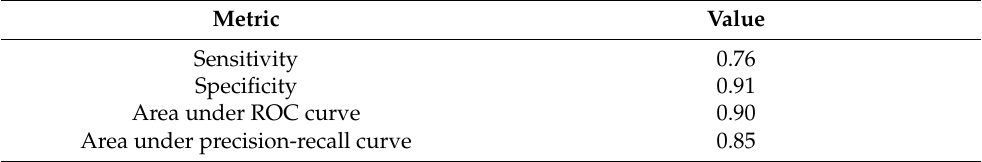
Figure 3. One of the pitfalls of the algorithm; tendency to misclassify sebaceous glands as tumor tissue. ( A ) Ground truth (tumor-free tissue with sebaceous glands). ( B ) Segmented areas by the algorithm considered as tumor. Table 3. Sensitivity, Specificity, Area under the precision-recall curve, area under the ROC